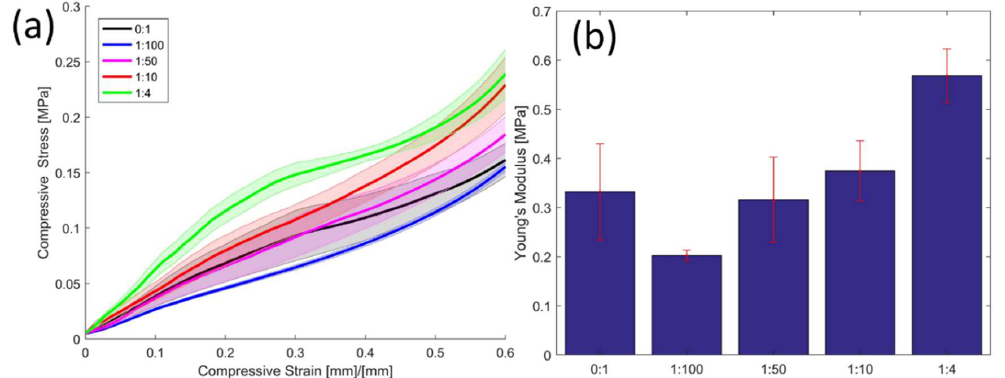
Figure 7. Unconfined compression testing of aerogels: ( a ) stress–strain curves and ( b ) compressive Young’s modulus calculated from the linear elastic range of the stress–strain plot. Legend indicates the ratio of XG:CNC.